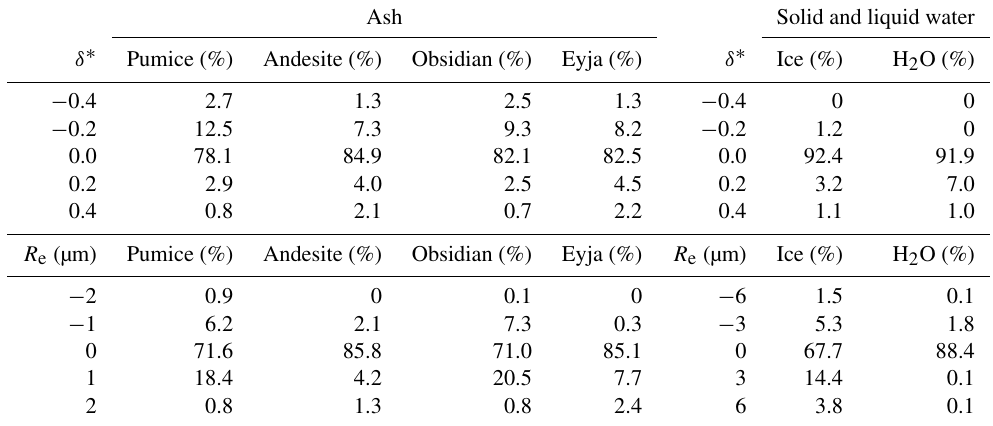
Table 2. Five central bins of the distributions of the differences (VPR retrievals minus true values) for the optical depth and the effective radius, obtained from the simulations performed for the Icelandic Eyjafjallajökull volcano cases. “Eyja” represents a kind of ash collected in the Eyjafjallajökull area after the 2010 eruption (D. Peters, private communication, 2013). Ash Solid and liquid water δ ∗ Pumice (%) Andesite (%)